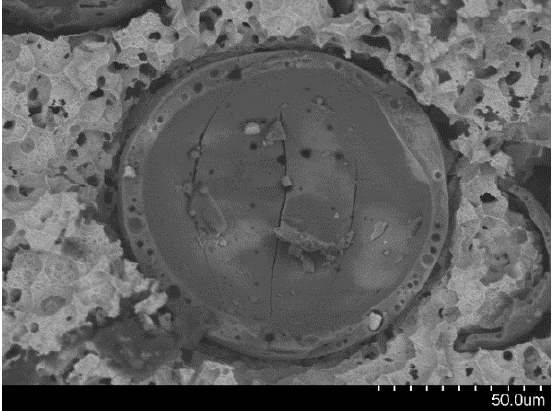
Figure 10. SEM images showing the cenosphere fracture in: ( a ) Invar ‐ 5CS; and ( b ) Invar ‐ 10CS at a strain of 5%.